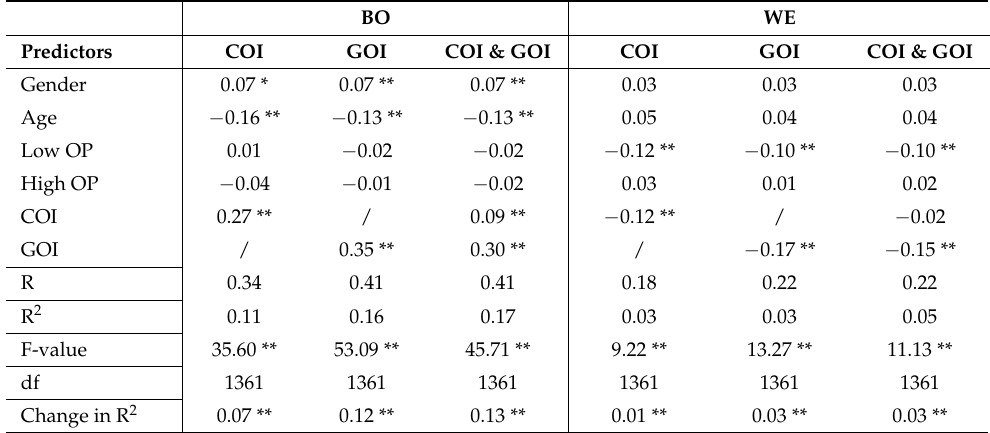
Table 4. Linear regression results for the relationship of occupation insecurity with burnout and work engagement.